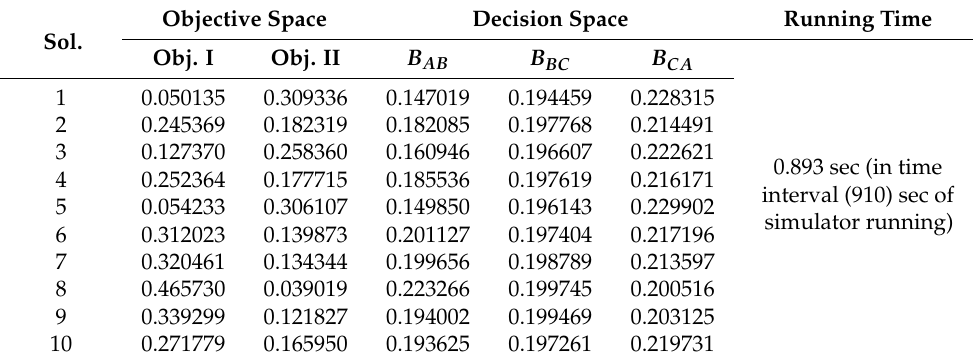
Table 2. Some solutions derived from the determined Pareto front. Objective Sol.